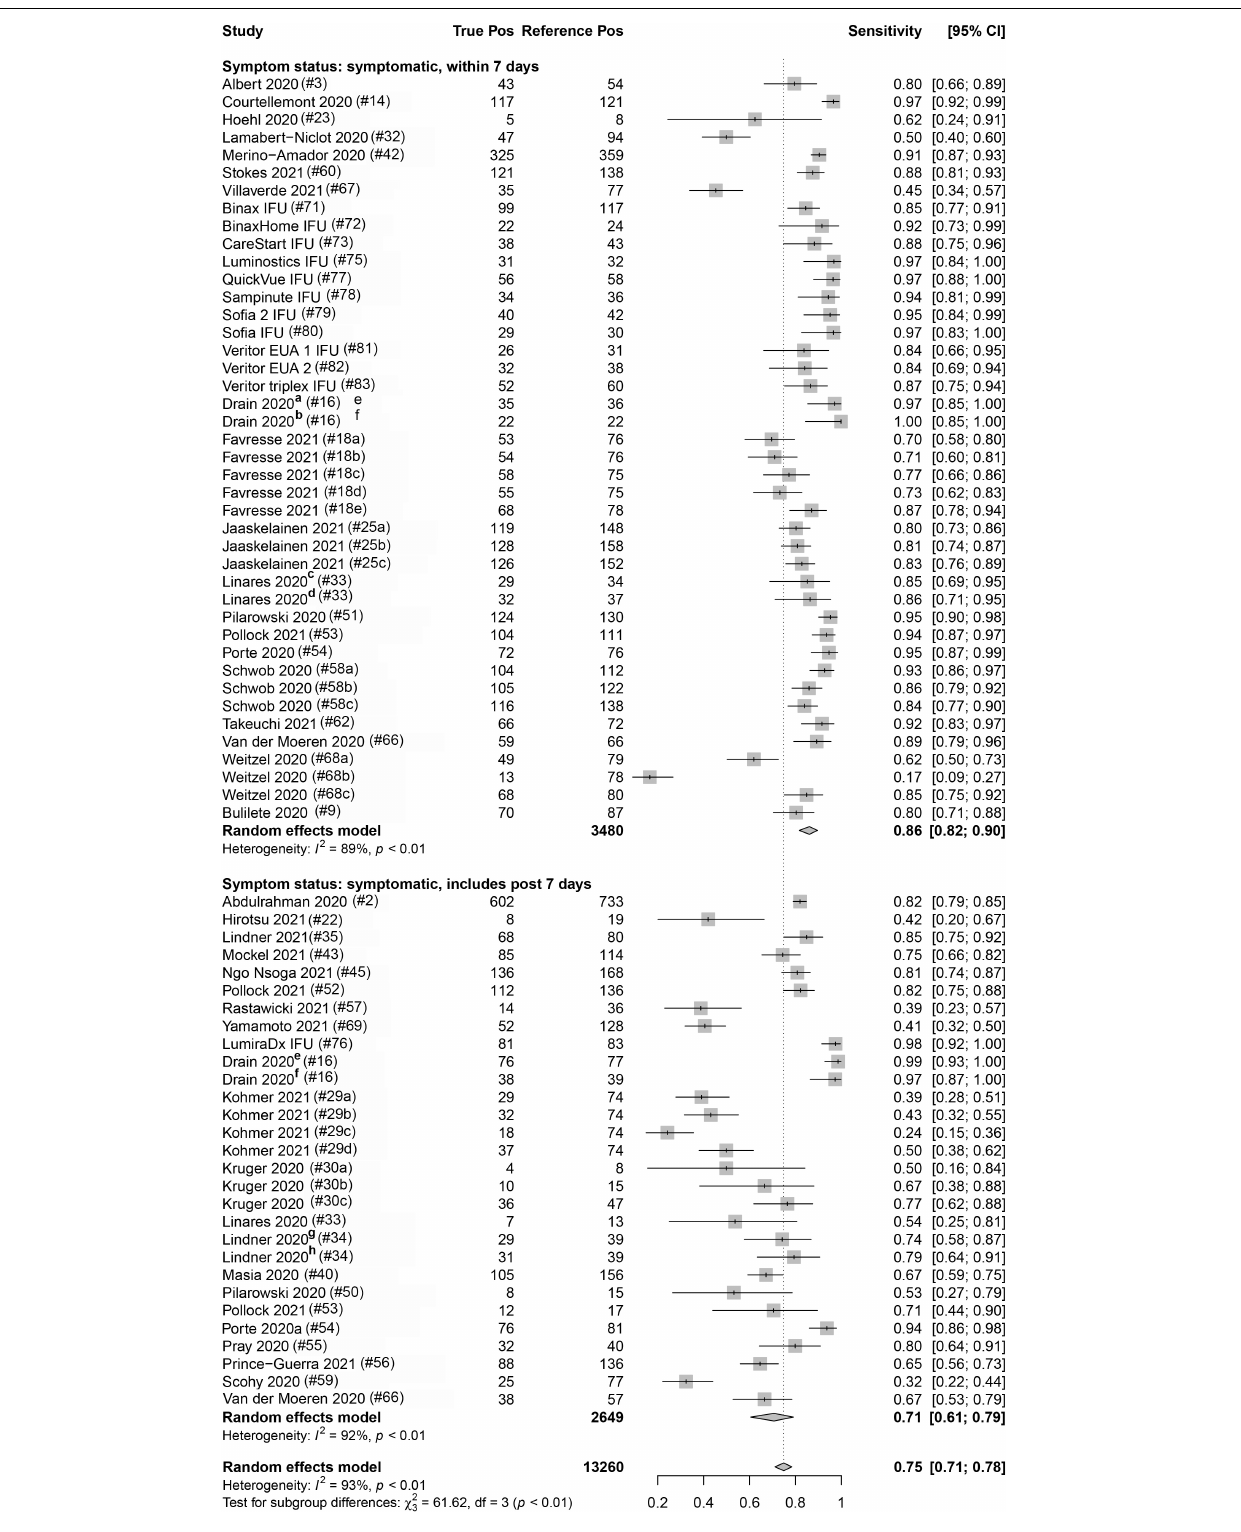
FIGURE 4 | Forest plots containing calculated sensitivity values for index [severe acute respiratory syndrome coronavirus-2 (SARS-CoV-2) antigen test] testing compared to reference [SARS-CoV-2 quantitative reverse transcription polymerase chain reaction (RT-qPCR assay)] test. Data are stratified by days from symptom